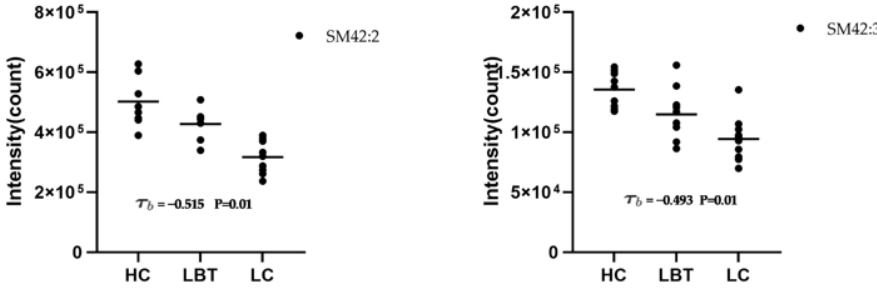
Figure 4. Mean plot of SM 42:2, SM42:3 among LC, LBT, and HC groups (SM 42:2: sphingomyelin 42:2; SM 42:3, sphingomyelin 42:3; LC, laryngeal cancer patients; LBT, laryngeal benign tumor patients; HC, healthy crowds).